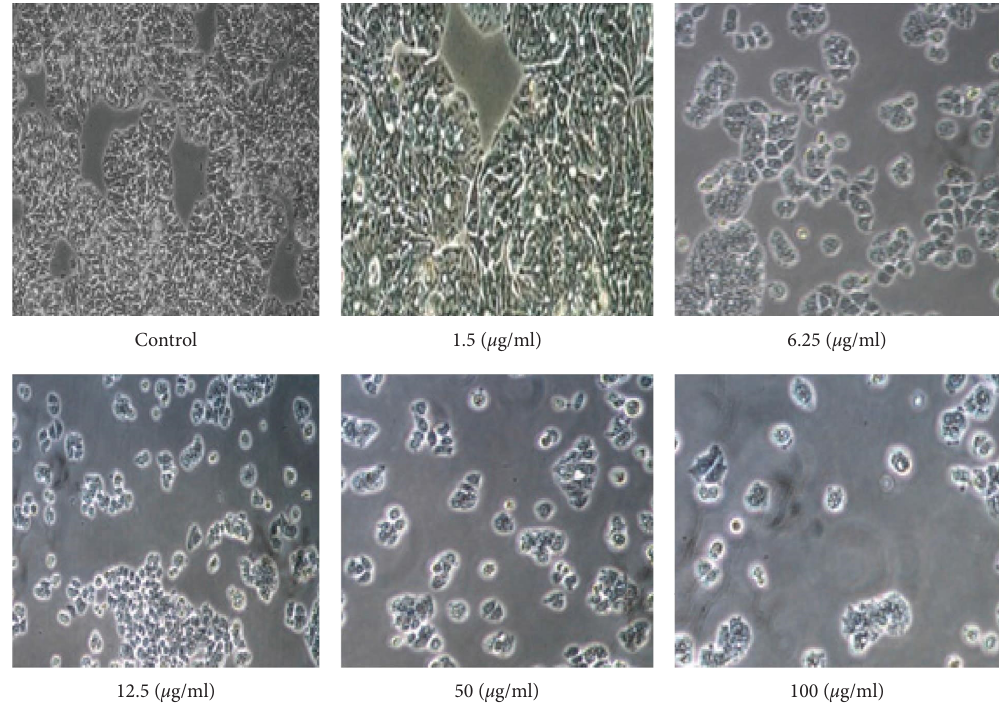
Figure 12: Morphological alterations in MCF-7 lines caused by diferent dosages of